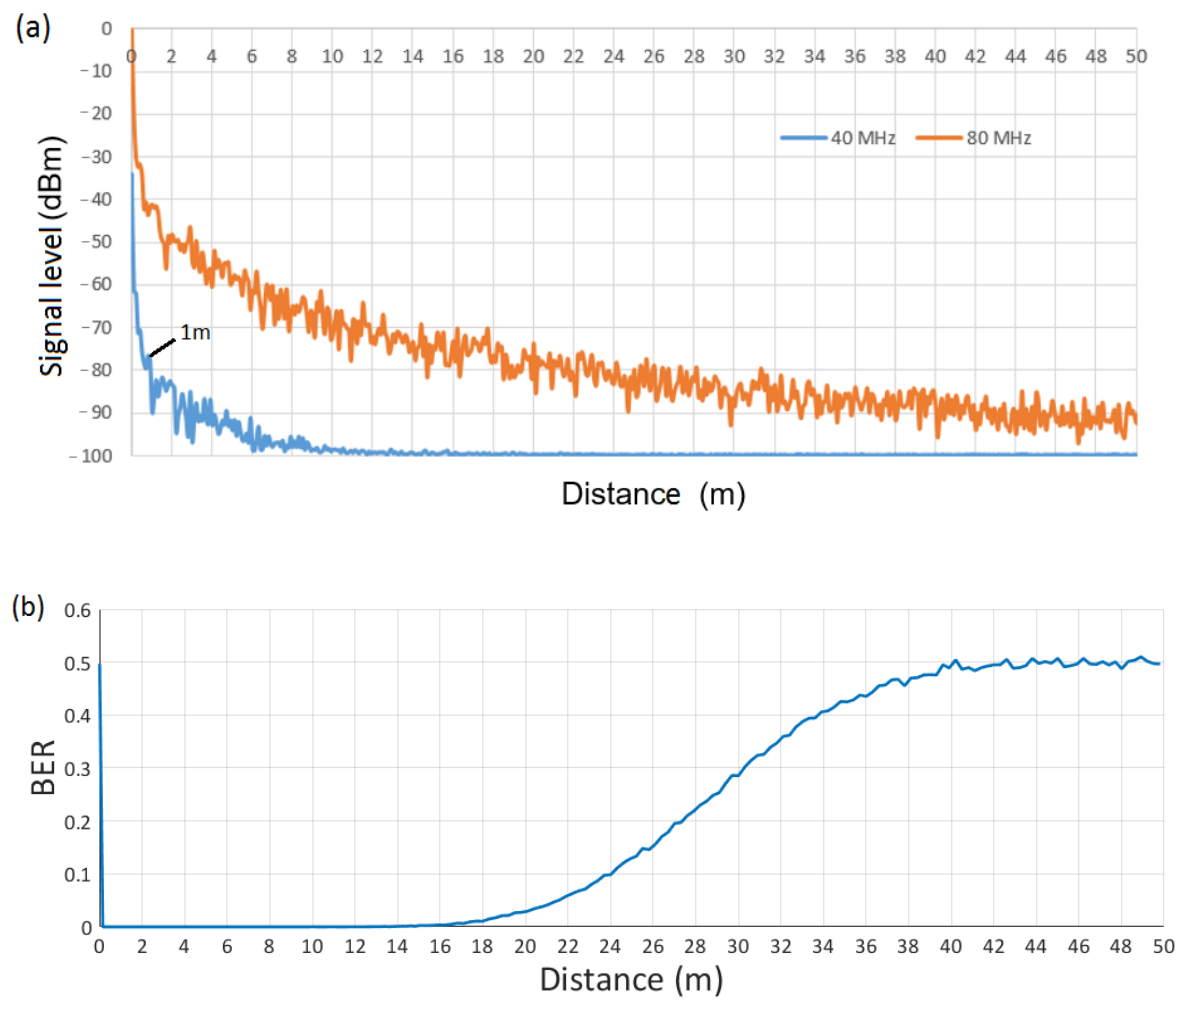
Figure 9. ( a ) Signal level at filter output of the second chain of Figure 6, ( b ) BER at the output of the second chain of the WuRx of Figure 6, vs. distance, employing 40 MHz and 80 MHz signals.